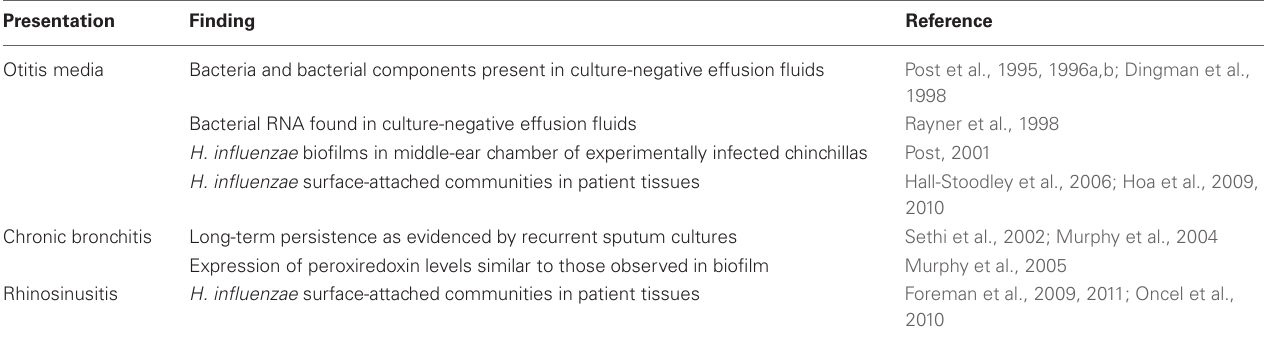
Table 1 | Clinical presentations of Haemophilus influenzae with a biofilm